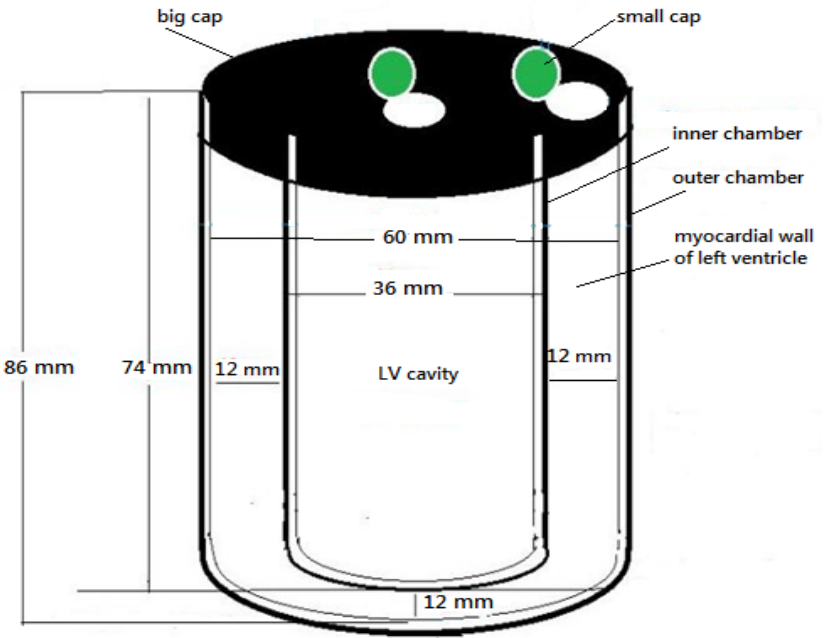
Figure 1. Schematic phantom to simulate myocardial wall of the left ventricle with two solid plastics.